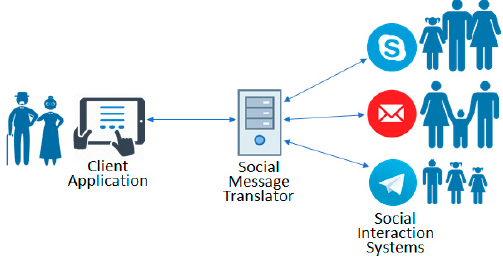
Figure 1. Architecture of the Interaction Scenario.